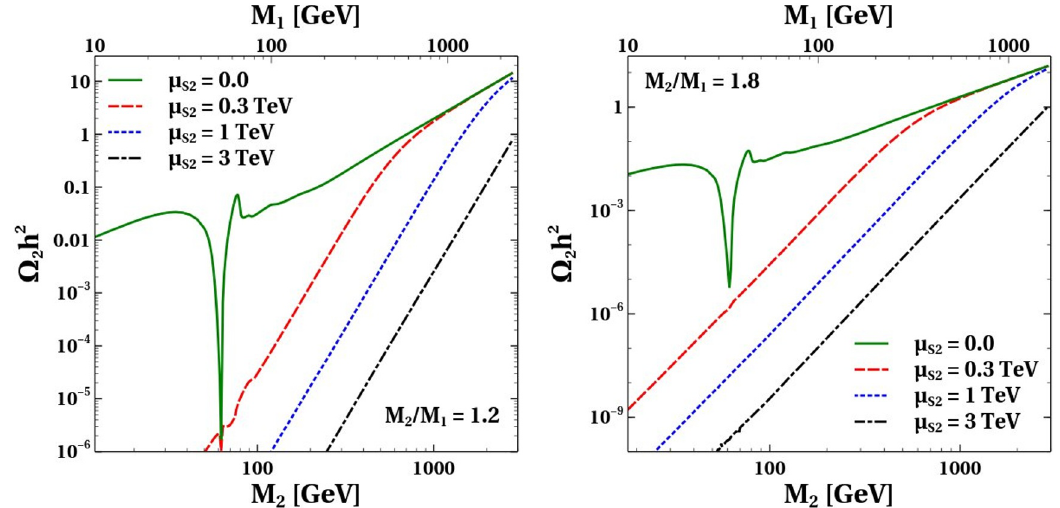
Figure 8 . The e(cid:11)ect of (cid:22) S 2 on (cid:10) 2 for M 2 =M 1 = 1 : 2 (left panel) and M 2 =M 1 = 1 : 8 (right panel). There is no appreciable e(cid:11)ect on (cid:10) 1 for the values considered in this